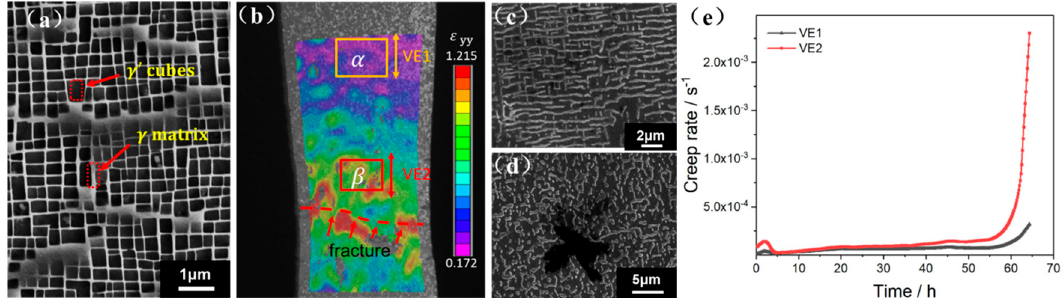
Figure 7. ( a ) The original microstructure of IC21 SX alloy after standard heat treatment; ( b ) the ε yy strain map of the TW specimen before the creep rupture from the DIC result; ( c ) the microstructure of the area of α (far from the fracture); ( d ) the microstructure of the area of β (near the fracture); ( e ) the creep rate of VE1 and VE2 during the creep test.